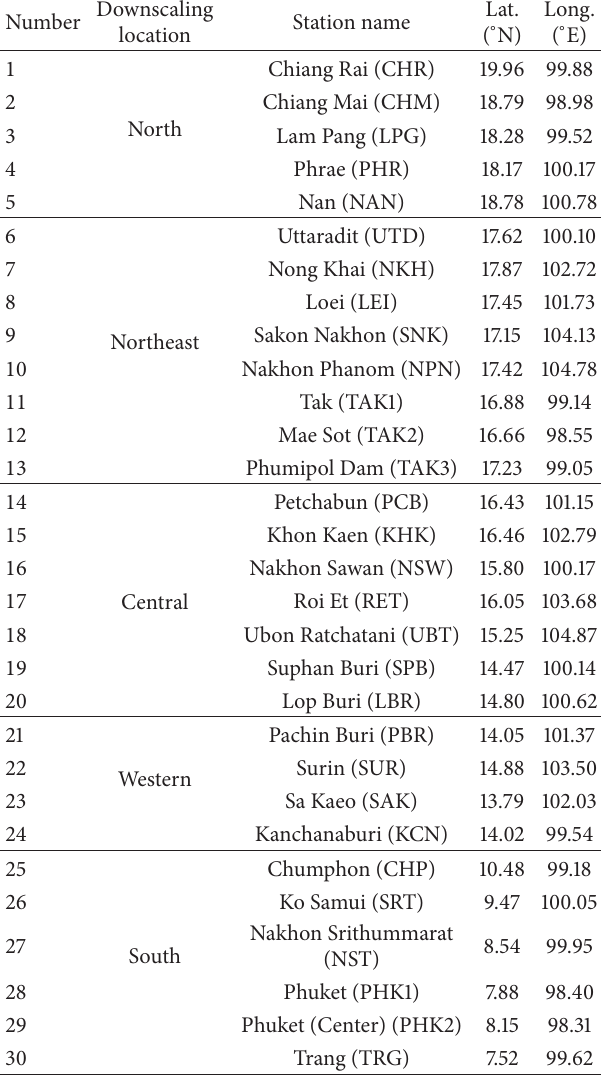
Table 2: The locations of the thirty meteorological stations in the five regions in Thailand